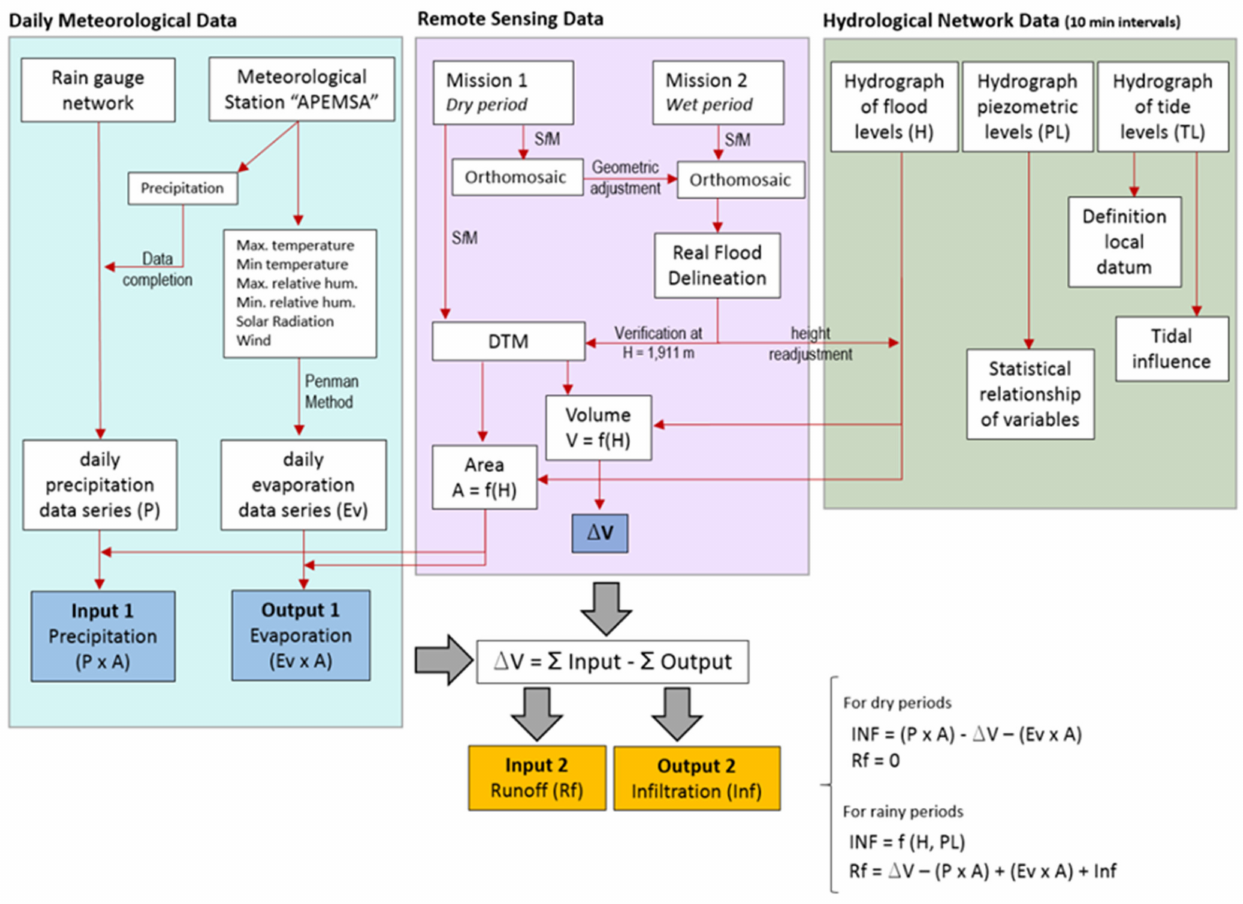
Figure 4. Workflow followed in this